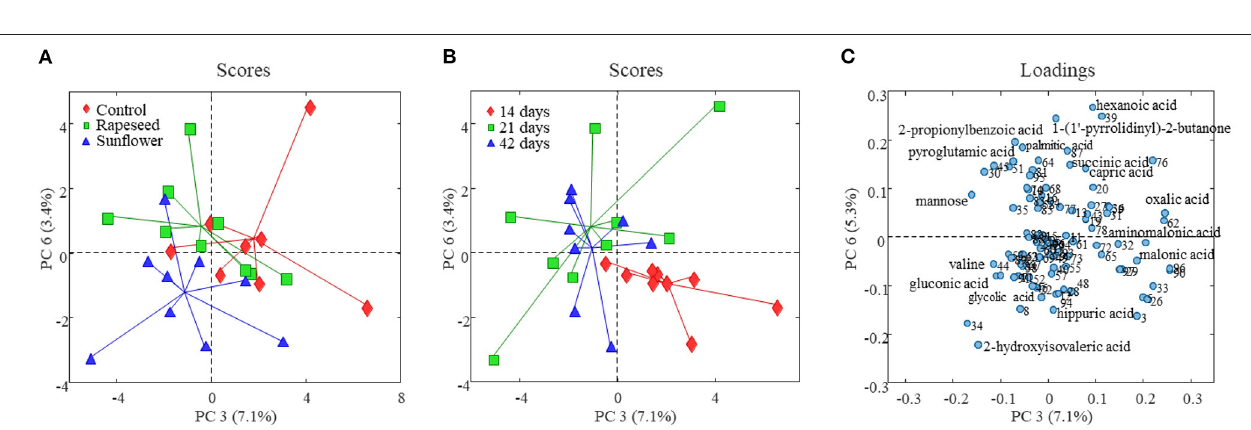
FIGURE 1 | Score and loading plots of the PCA model developed on goat milk NMR foodomics data. (A) PC3 vs. PC6 score plot and milk samples are color coded according to the dietary treatment, and in panel (B) , milk samples are colored according to the experimental period. (C) PC3 vs. PC6 loading plot from the corresponding PCA model (variables are numbered as in Supplementary Table S2 ).